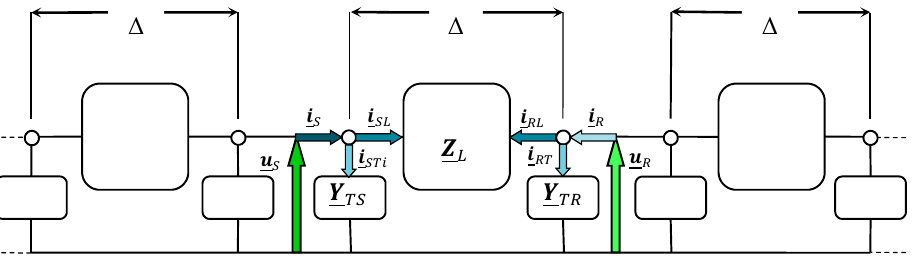
Figure 1. Elementary cell cascade for single-circuit cable line modelling.